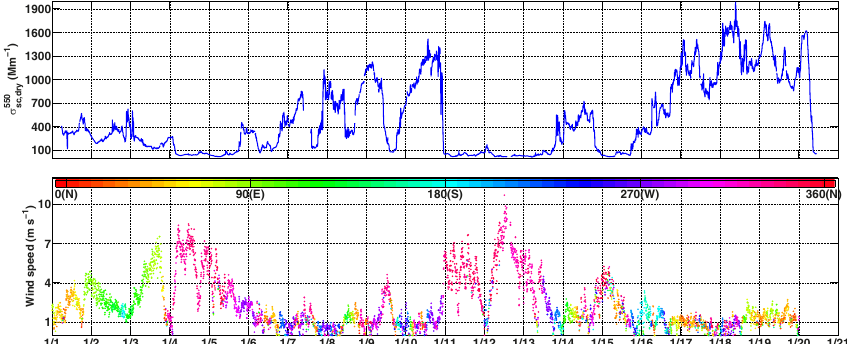
) under dry conditions, along with the wind sc , dry